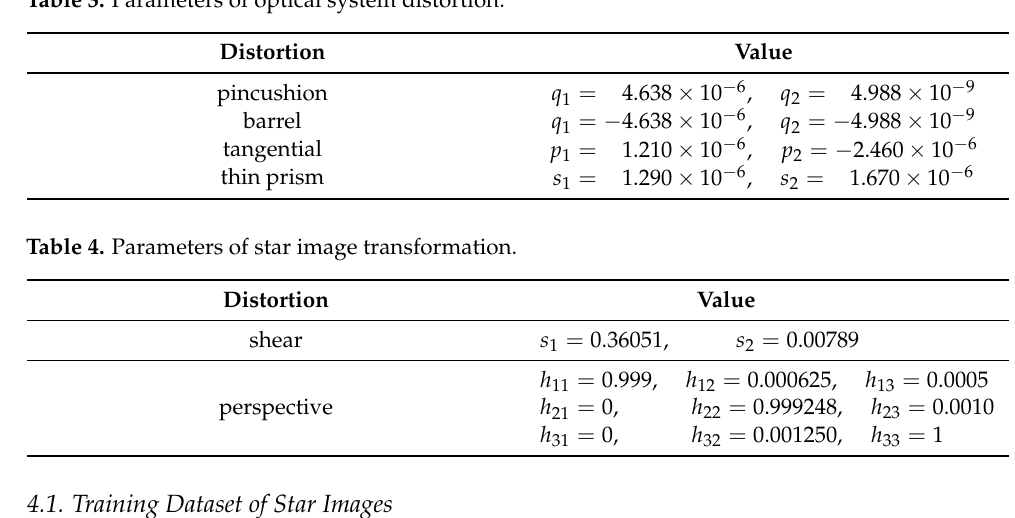
Table 3. Parameters of optical system distortion.